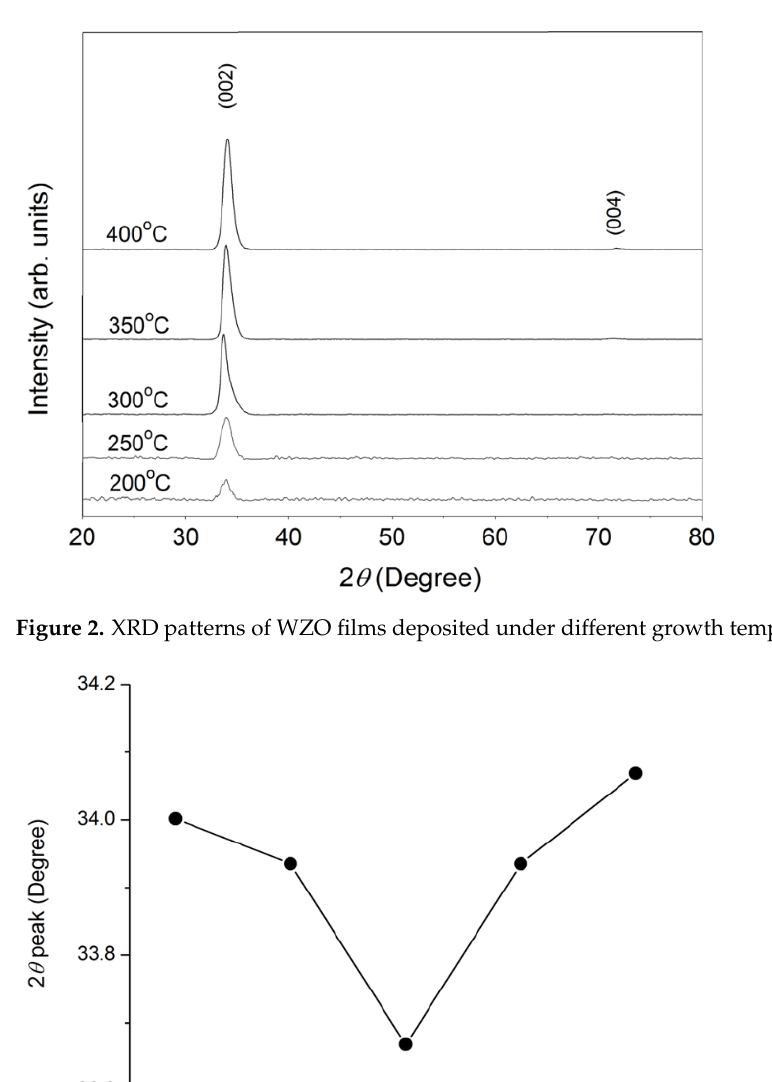
Figure 2. XRD patterns of WZO films deposited under different growth temperatures (200 – 400 °C).